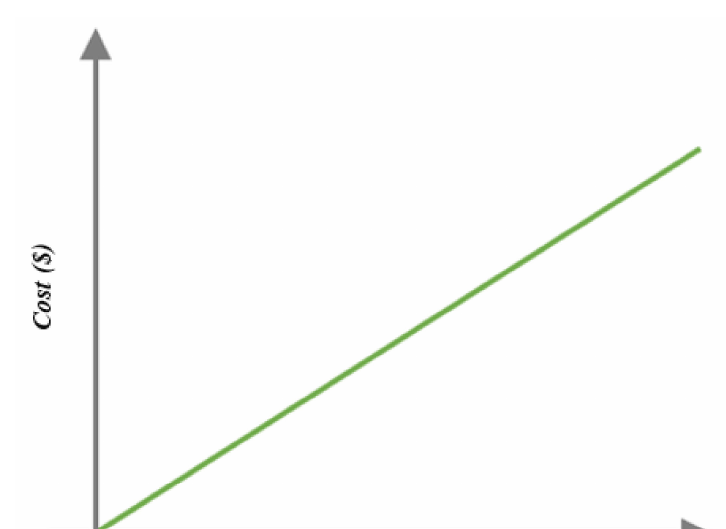
Figure 7. Electricity cost.